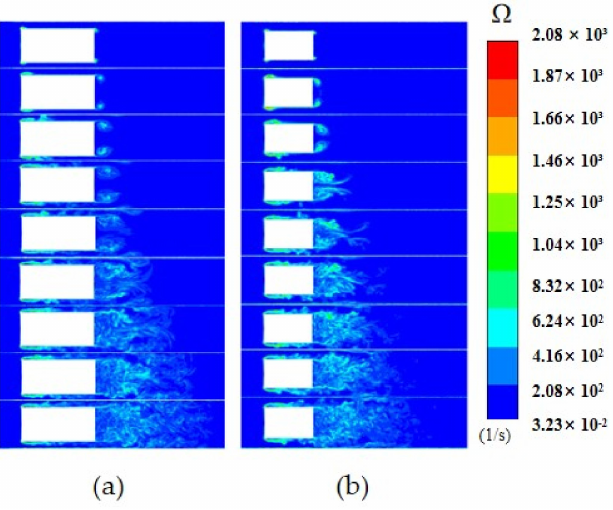
Figure 11. Vorticity distribution at different moments: ( a ) K = 0.5; ( b ) K =